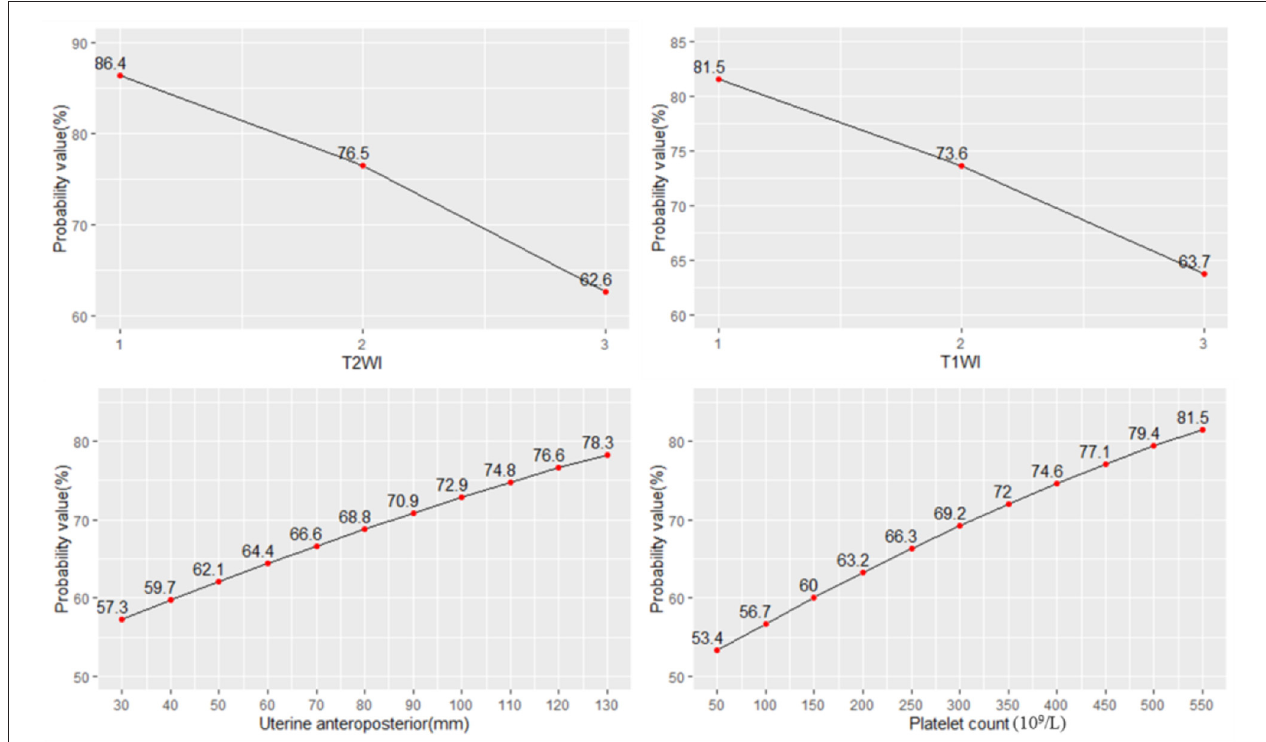
FIGURE 3 | The probability of NPVR reaching 80% based on the four most important independent